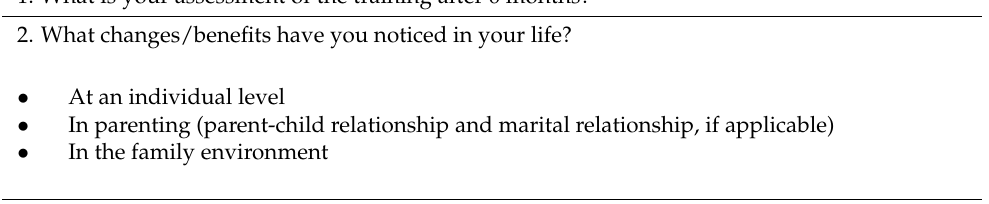
Table A4. Questions from follow-up